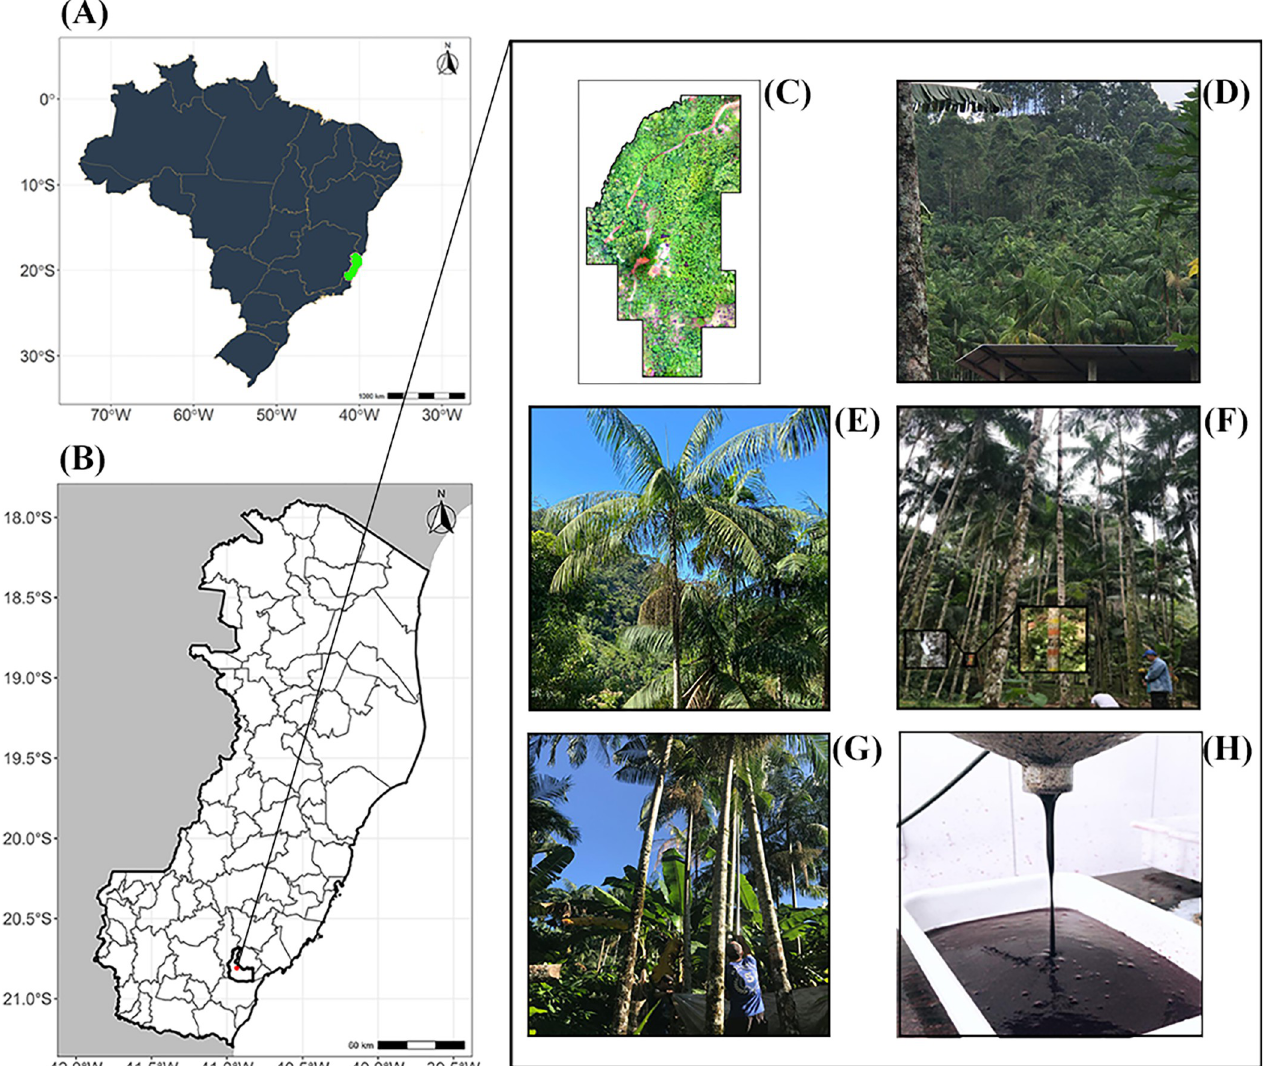
Fig 1. Geographical location of the experimental field. Geographical location of the experimental field where the Euterpe edulis genotypes are located. Map generated with R free environment software . (A) Delimitation of Brazil, in green, the geographic location of the state of Espı ´ rito Santo; (B) Graphic representation of the state of Espı´rito Santo, in red, the location of the municipality of Rio Novo do Sul; (C) Orthomosaic of the experimental area; (D) Image referring to a fragment of the experimental planting; (E) Juc¸aizeiro ( Euterpe edulis ) from experimental planting in productive phase; (F) Registration of genotypes identification in field; (G) Juc¸aizeiro ( Euterpe edulis ) fruits harvest; (H) Processed pulp of juc¸aizeiro ( Euterpe edulis ) fruits.